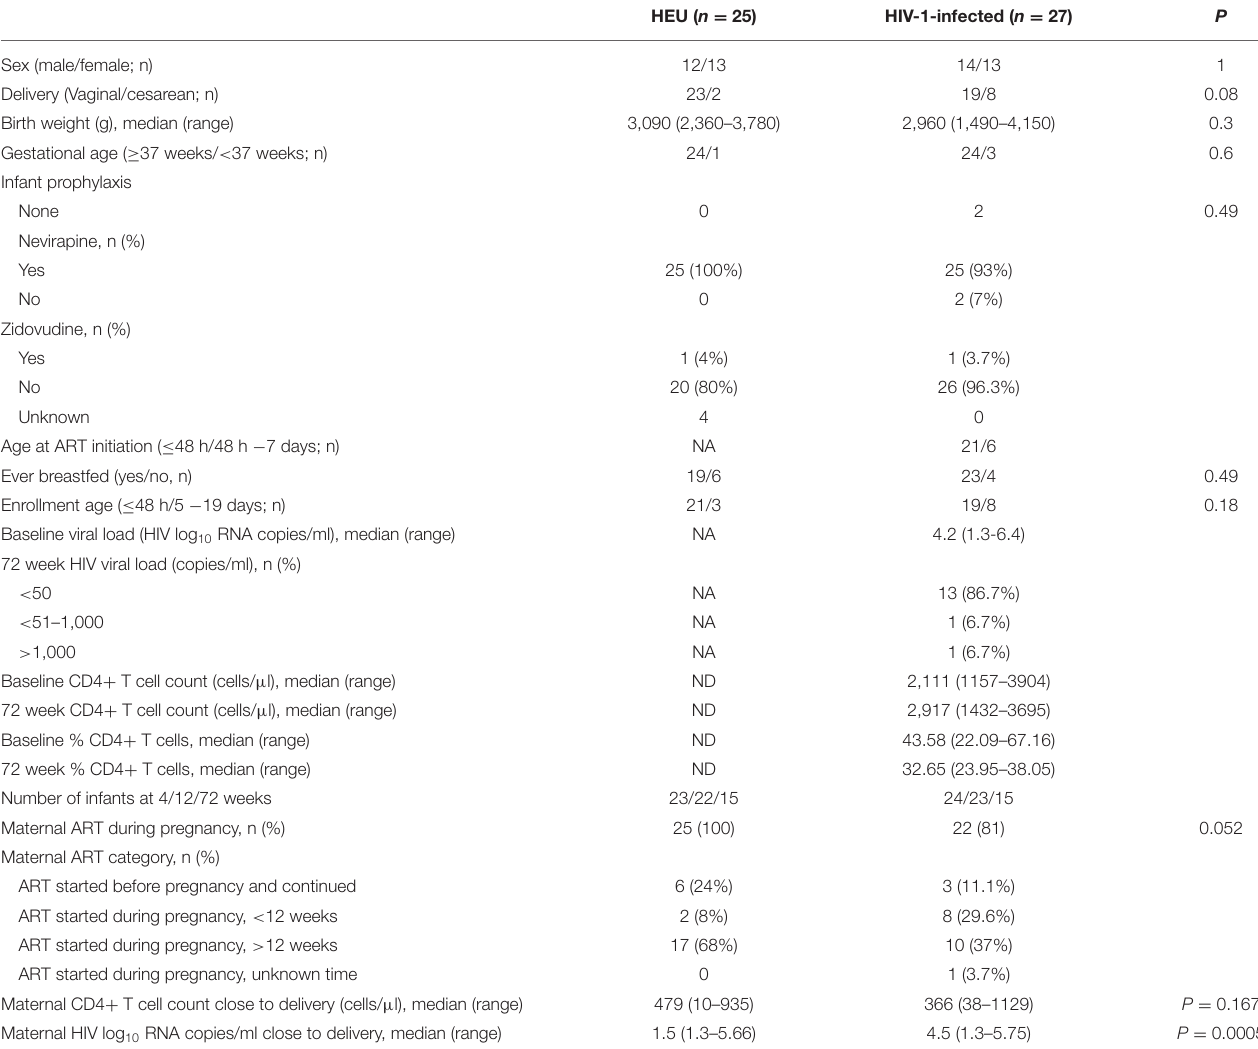
TABLE 1 | Characteristics of HIV-exposed uninfected (HEU) and HIV-1-infected infants.